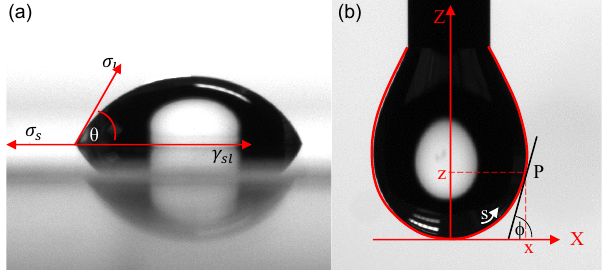
Figure 1. Visual of the drop shape analysis of (a) a contact angle and (b) the surface tension pendant drop using the Kruss Easy Drop. The images are of the control solution (HNS + HNS) taken at 90s. Figure is based off of figures appearing in the Kruss User’s Manual (Kruss,